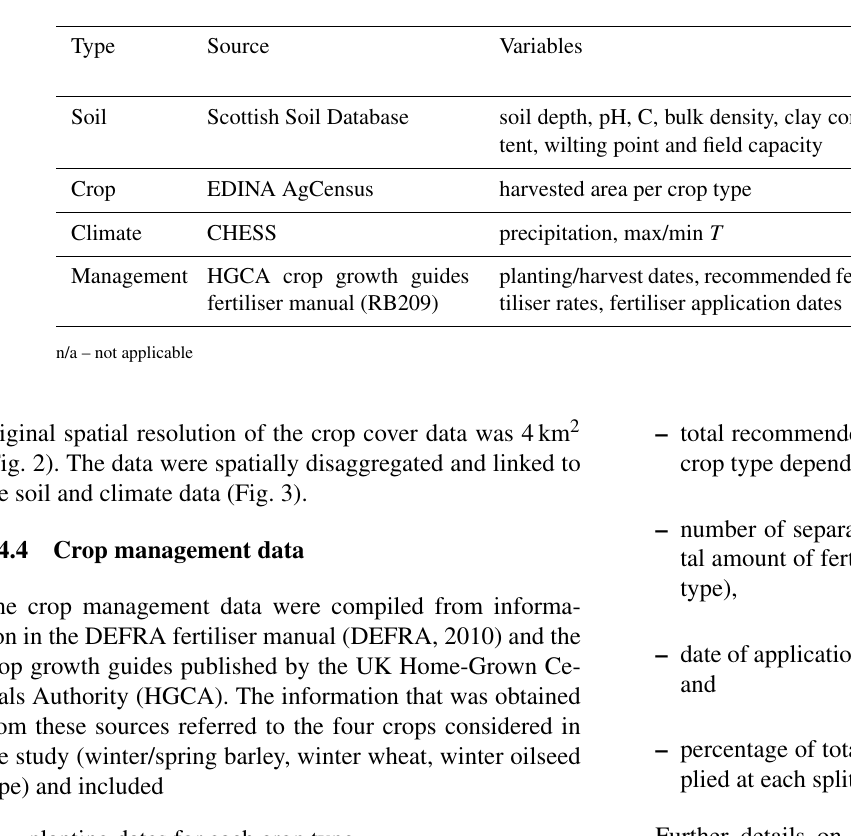
Figure 1. Schematic description of the process that is used to quantify the relative uncertainty of regional predictions. EF: emission factor;